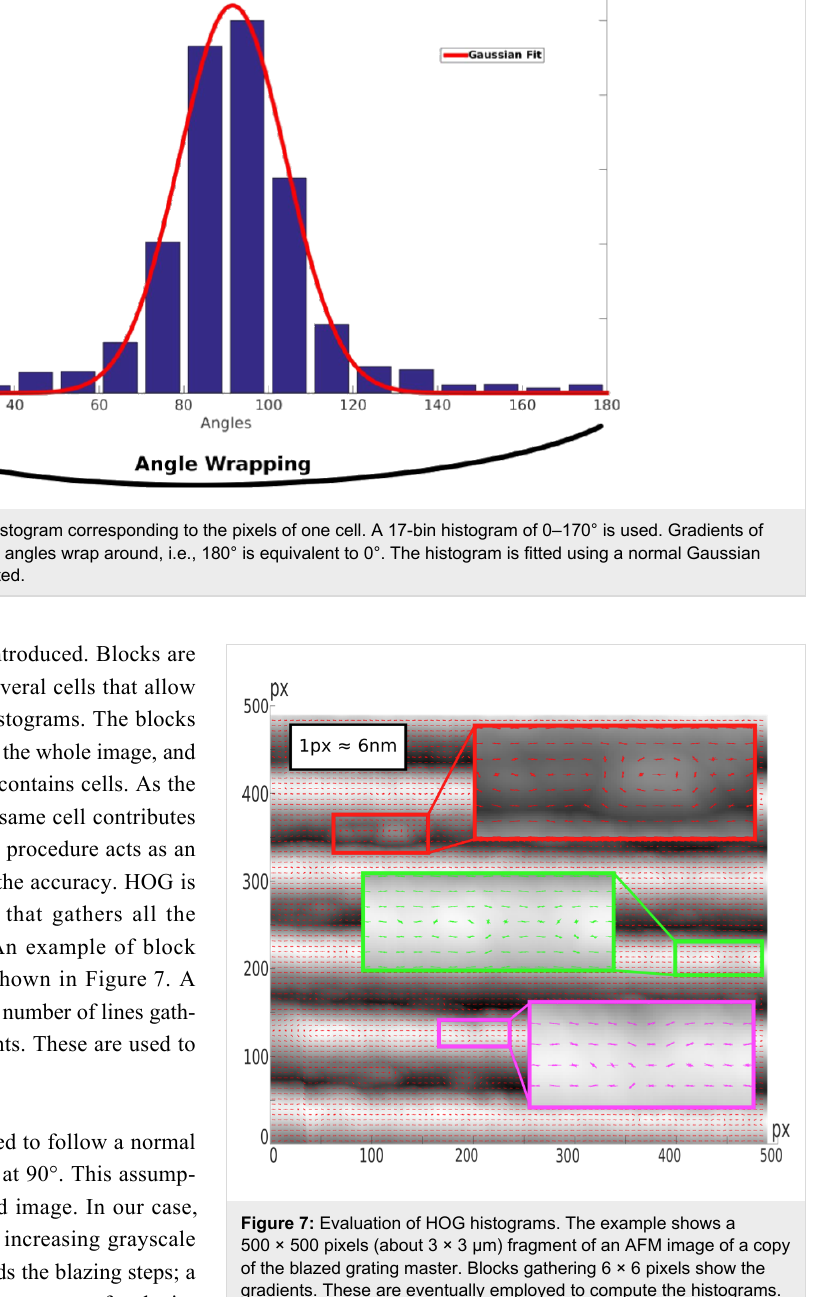
The histograms of some parameters are gathered in groups. This is partially due to data processing. Data are obtained from